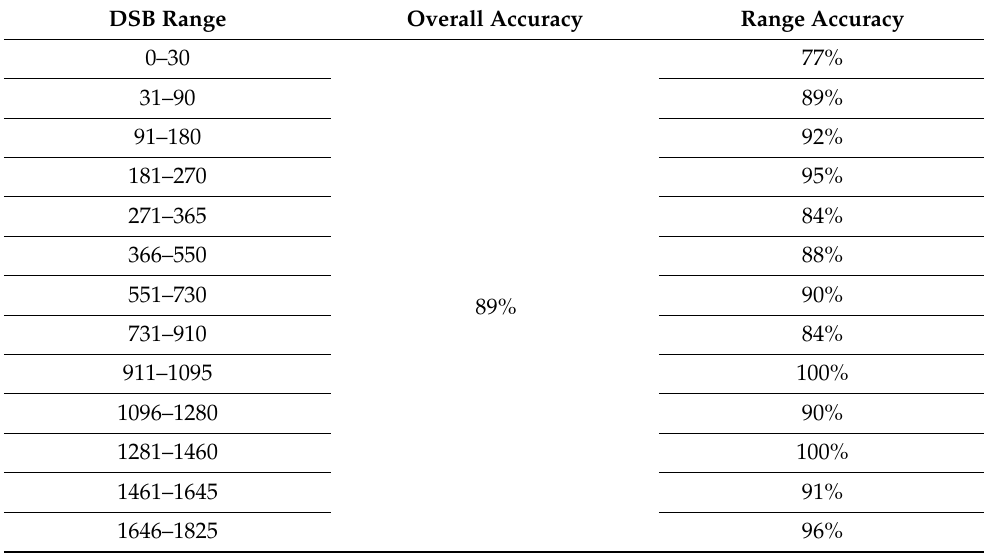
Table 4. Performance of random forest classification algorithm for different age groups.